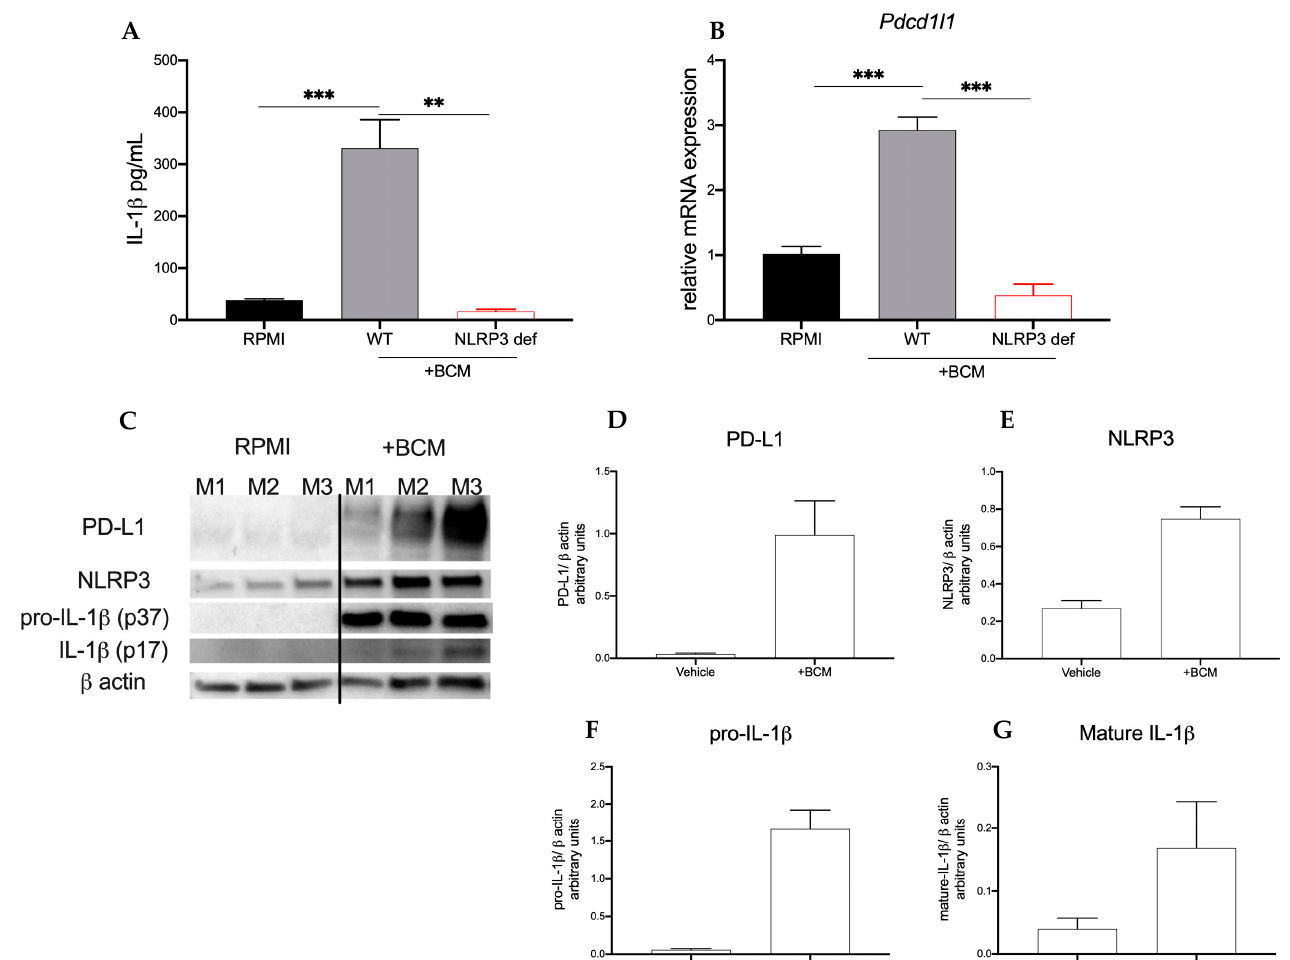
Figure 2. Breast cancer cells induce myeloid NLRP3 and PD-L1. ( A , B ) THP-1 or THP-1-NLRP3def cells were stimulated with MDA-MB-468-conditioned media (+BCM). ( A ) Mean ± SEM IL-1 β pro- duction from THP-1 or THP-1-NLRP3def cells left unstimulated (RPMI) or treated with conditioned media after 48 h ( n = 3). ( B ) Mean ± SEM of relative gene expression of Pdcd1l1 from cells described in ( A , B ) or stimulated with (+BCM) and treated with OLT1177 ( n = 3). ( C – G ) Bone marrow adher- ent cells stimulated with 4T1-conditioned media (+BCM). ( C ) Representative Western blot images from ( C – G ); mean ± SEM of PD-L1/ β -actin ratio ( D ), NLRP3/ β -actin ratio ( E ), pro-IL-1 β / β -actin ratio ( F ) and mature IL-1 β / β -actin ratio ( G ) from cells described in ( C – G ) ( n = 3). *** p < 0.001, ** p <